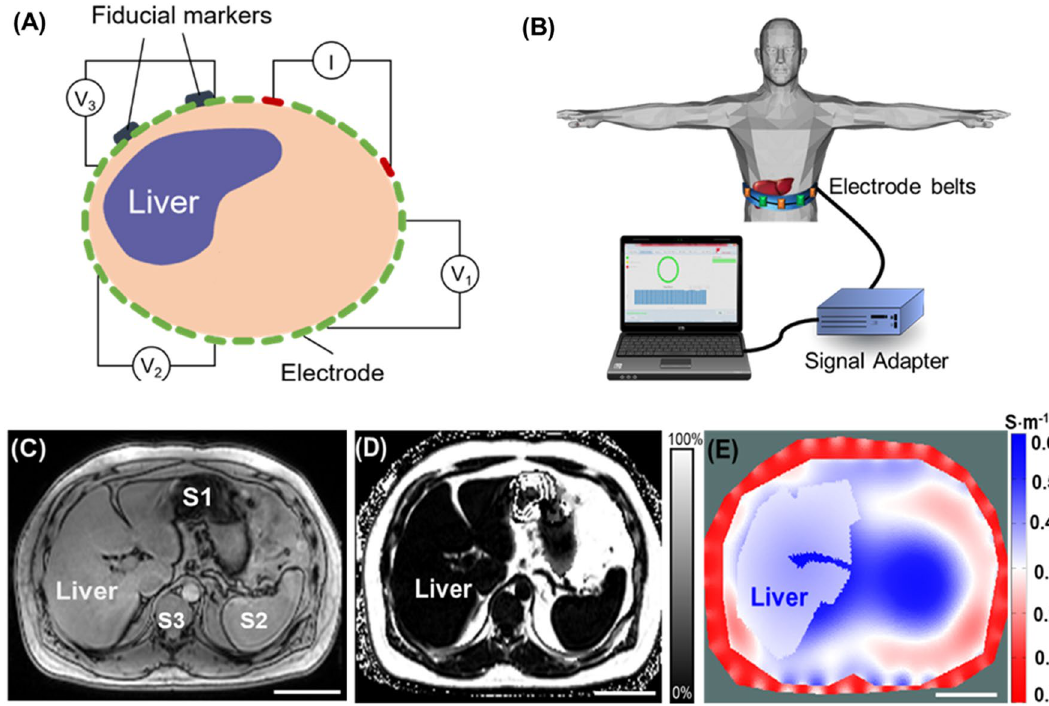
Figure 6. Schematic of EIT measurement, reconstruction, and 2-D representation. ( A ) Schematic illustrates circumferential electrode placement around the abdomen for pairwise voltage measurements. The fiducial markers indicate the anatomic level at which the multi-electrode array was circumferentially positioned for liver EIT measurements. ( B ) Thirty-two electrodes were adhered to the abdomen, as indicated by the fiducial markers. The recorded voltage signals were input to a signal adaptor and the data acquisition channels for EIT measurements. ( C ) A representative MRI multi-echo image demarcates the boundary conditions for the abdomen, liver, stomach, and spleen. S1: Stomach, S2: Spleen, S3: Spine. ( D ) A representative PDFF map is compared with the corresponding EIT image. ( E ) A representative 2-D EIT image reveals the conductivity distribution. Scale bar: 8